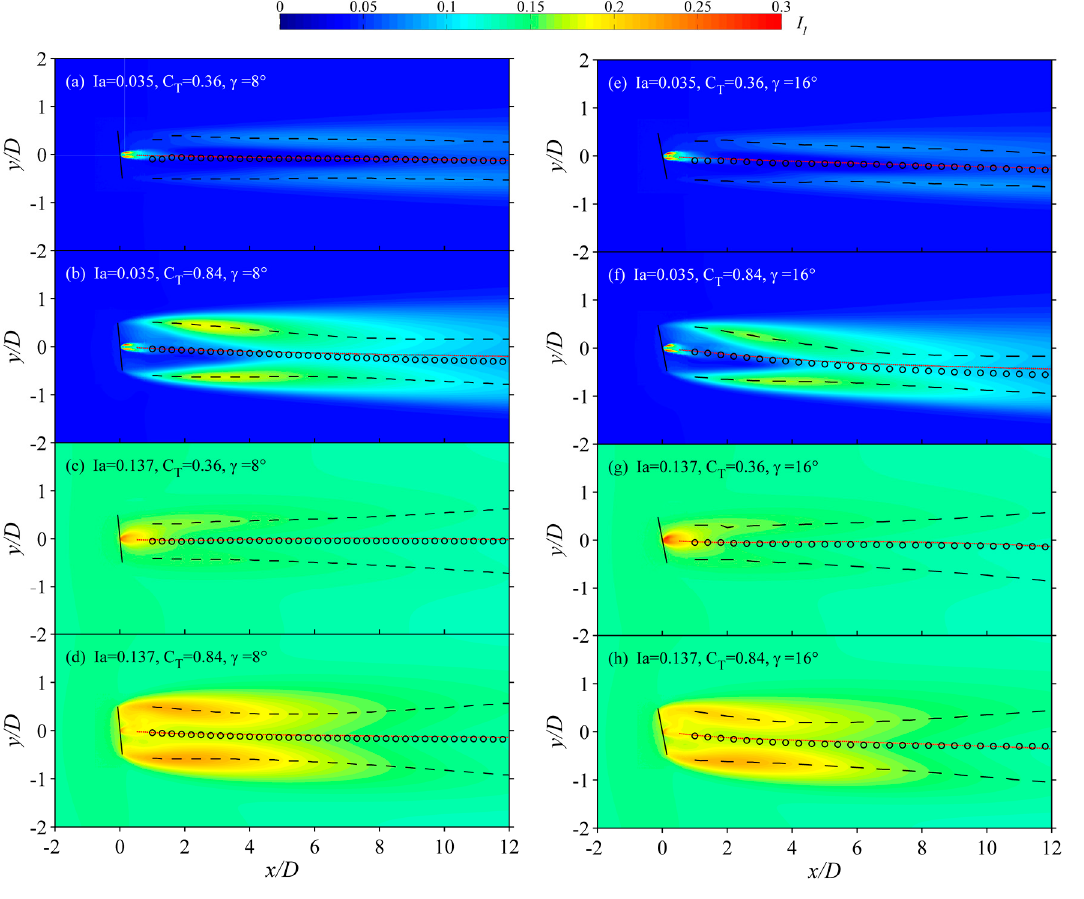
Figure 7. Contours of turbulence intensity and wake deflections in the horizontal x - y plane at the hub height. Solid lines represent the wind turbine rotors. Dashed lines denote the position of peak values of turbulence intensity and the midpoint of the two peaks are indicated by the open circles. The wake center trajectories obtained from the mean velocity contours are plotted by red dotted lines.